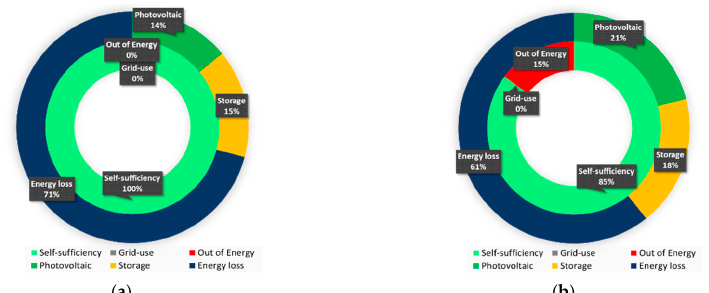
Figure 17. Energy balance for driven distances of 34 km/day: ( a ) off-grid charging station; ( b ) off-grid charging station with reduced energy losses.